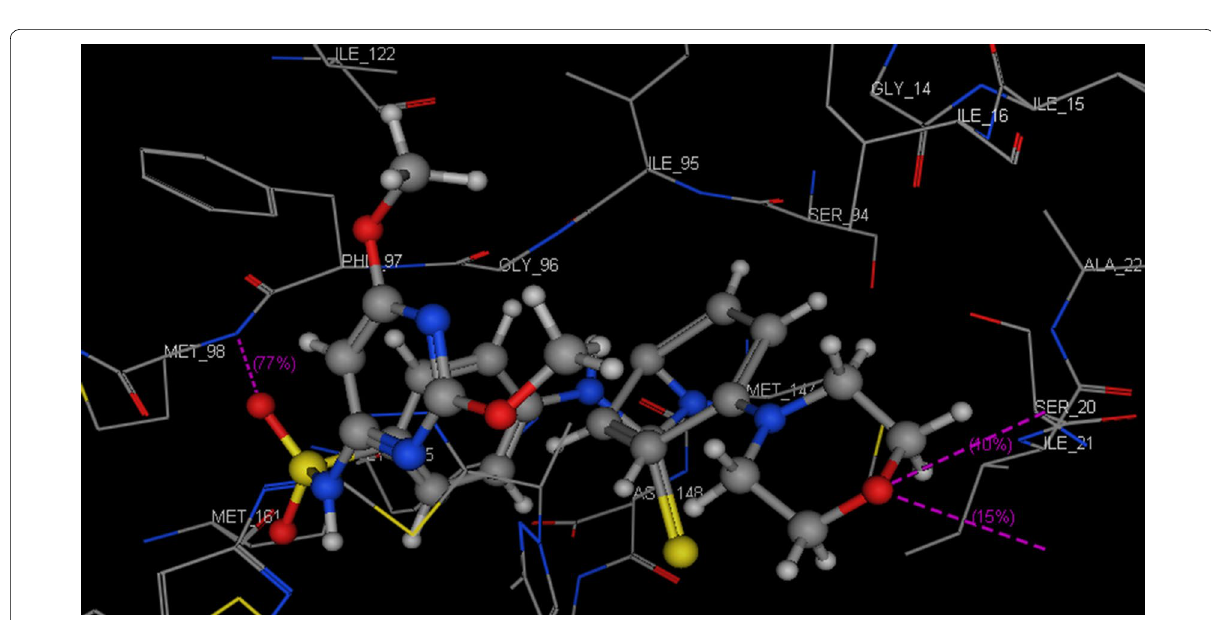
Fig. 5 3D docking of compound 3s (S